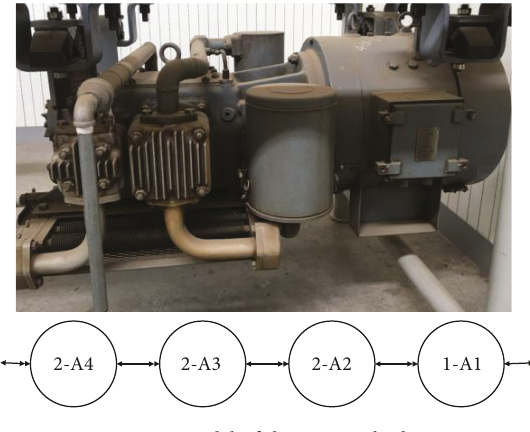
Figure 2: Model of the air supply